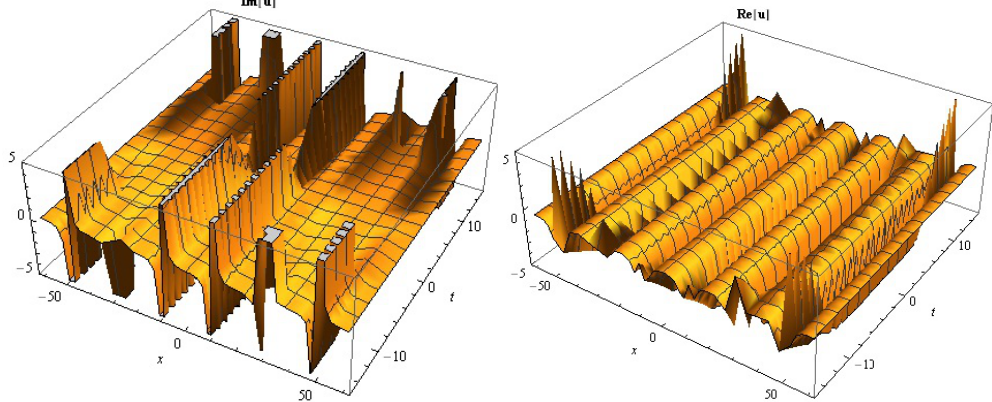
Figure 6. The 3D figures of u 6 for α 2 = 0.1, α 3 = 0.32, ε = 1, w = 0.012, A 2 = 0.5, c = 0.01, y =